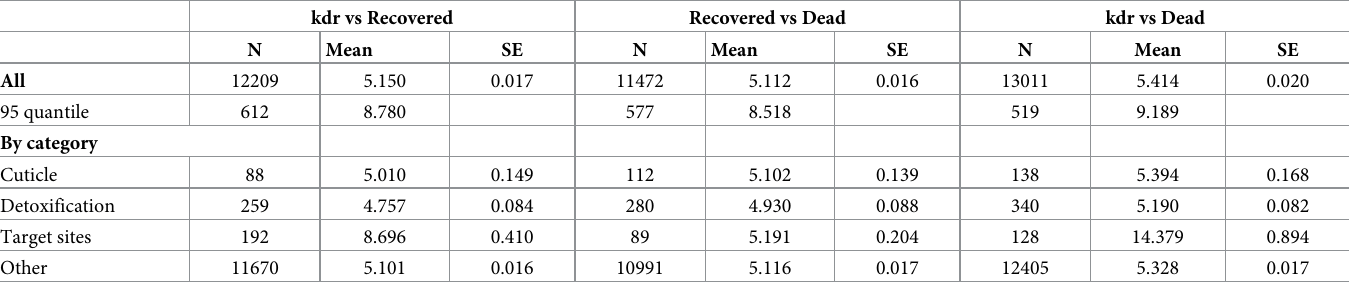
Table 1. Mean and standard error (SE) of LOD values (-log 10 ( p value )) assigned to SNPs differing between kdr, recovered and dead Aedes aegypti exposed to per- methrin. The number of SNPs (N) and the LOD mean and SE for three categories of genes associated with insecticide resistance are shown separately. kdr vs Recovered Recovered vs Dead kdr vs